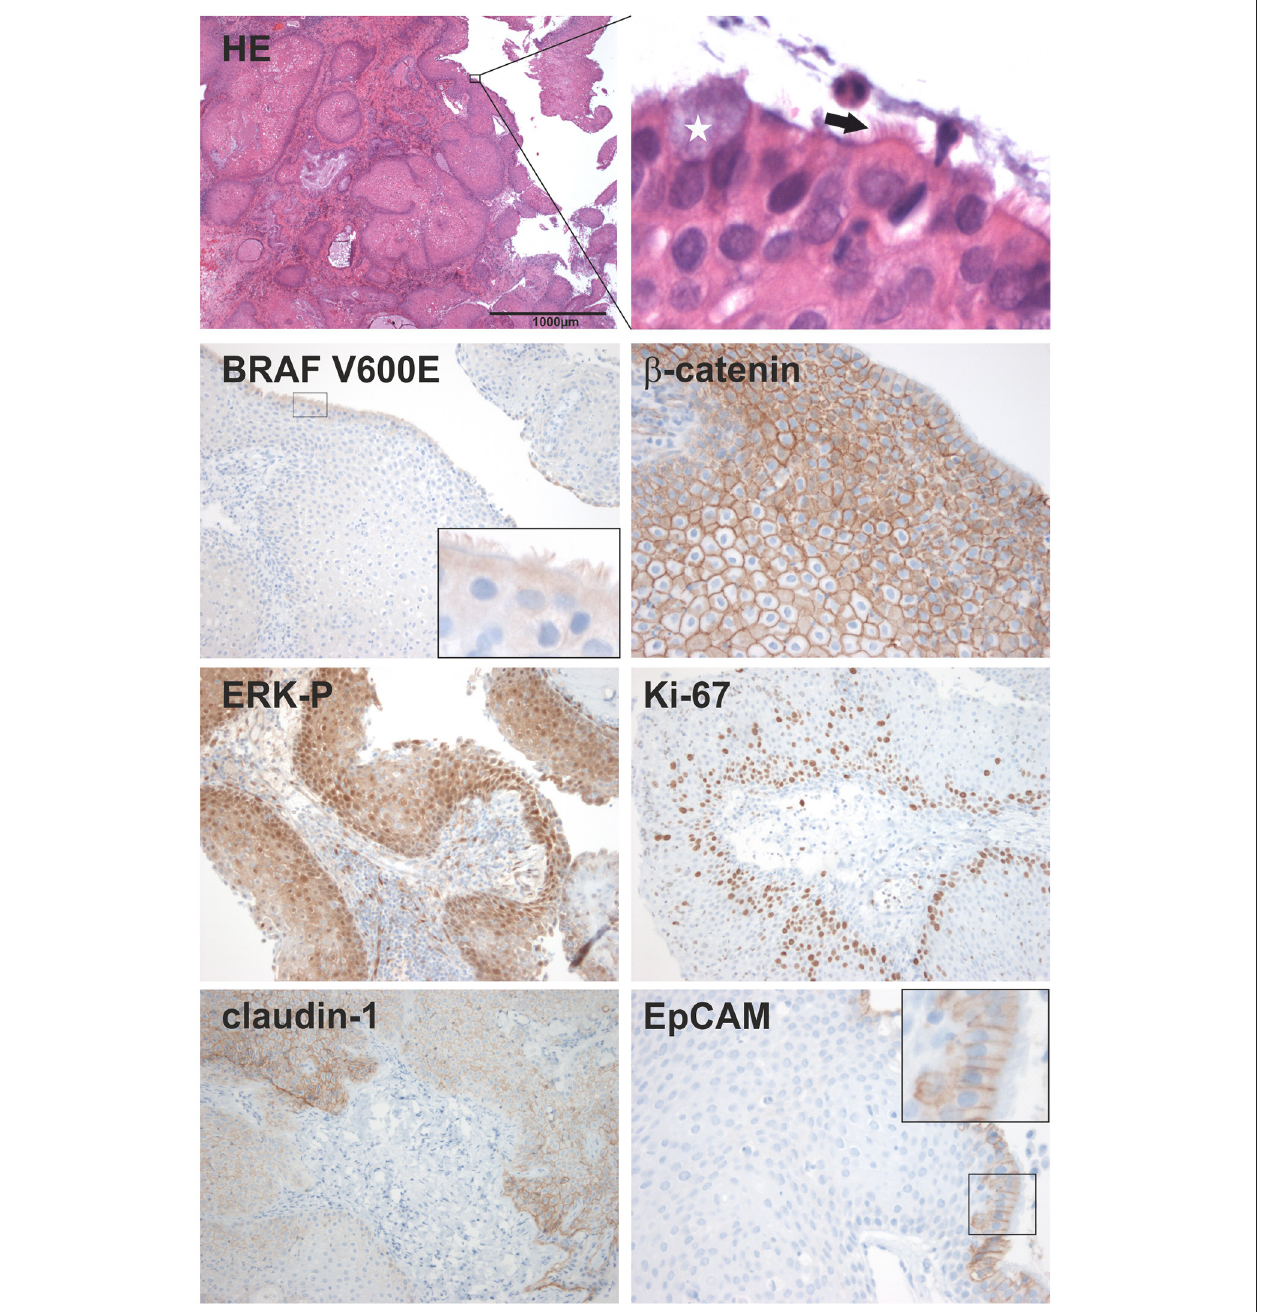
FIGURE 2 | Histological characterization; HE staining shows a lesion of squamous couple stone differentiated epithelium. Magnification revealed a superficial cell layer harboring kinocilia (arrow) and goblet cells (white star). The following immunohistochemical stainings show the evidence and expression pattern of the mutated BRAF V600E protein, beta-catenin; the phosphorylated ERK (ERK-P) and the proliferation marker Ki-67; as well as the distribution of the cell-cell contact proteins, claudin-1 and EpCAM. In a higher resolution, EpCAM is only detectable in ciliated cells of the superficial cell layer.